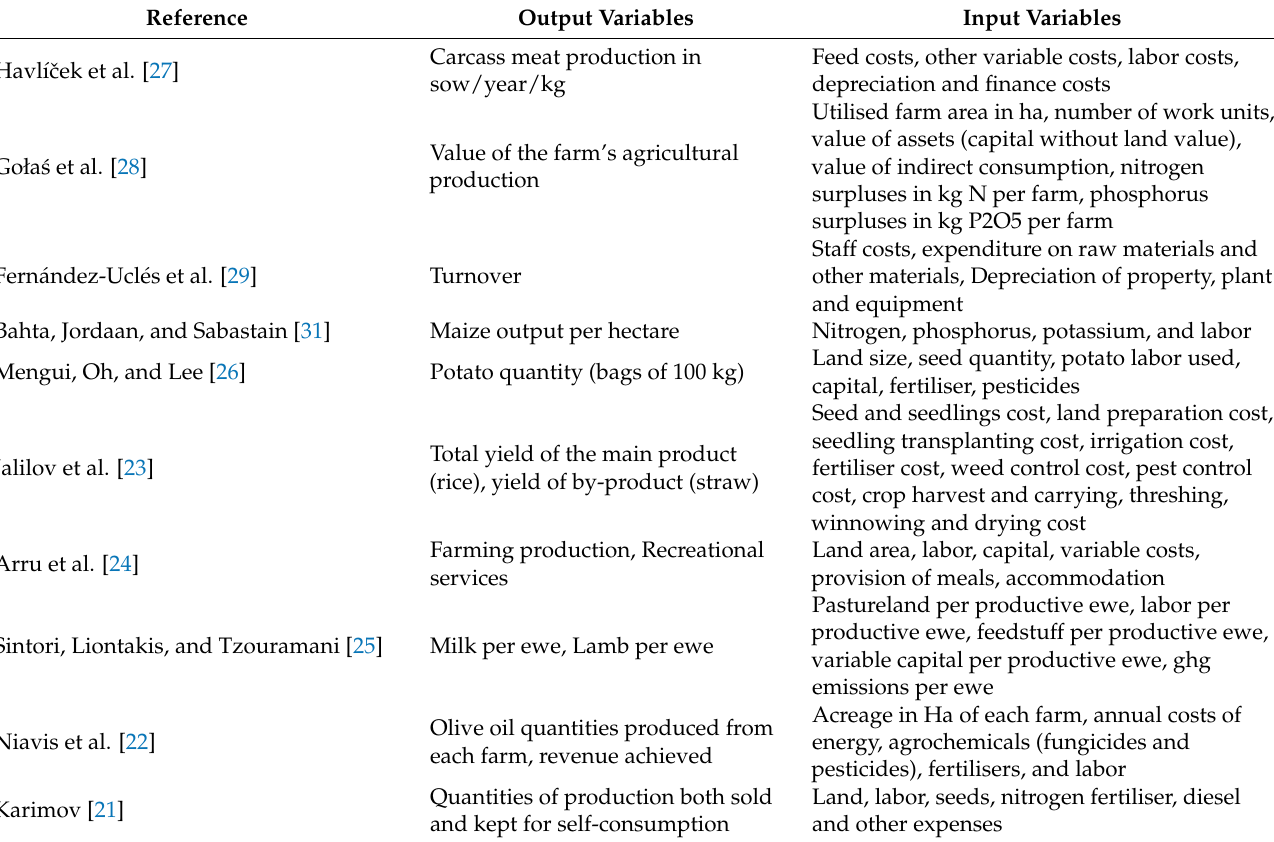
Table 2. Input–output variables used by agricultural efficiency researchers (Source: Own